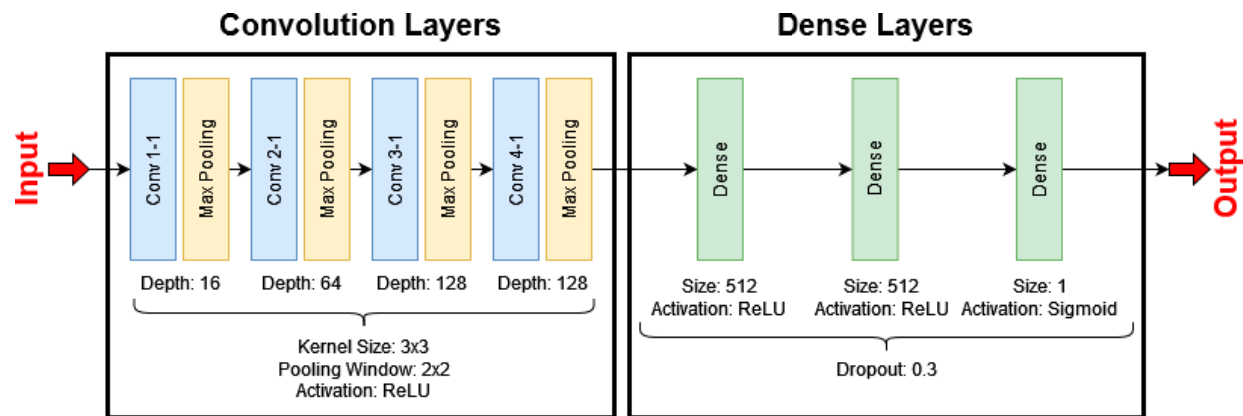
Figure 6. Rudimentary CNN model architecture with regularization.